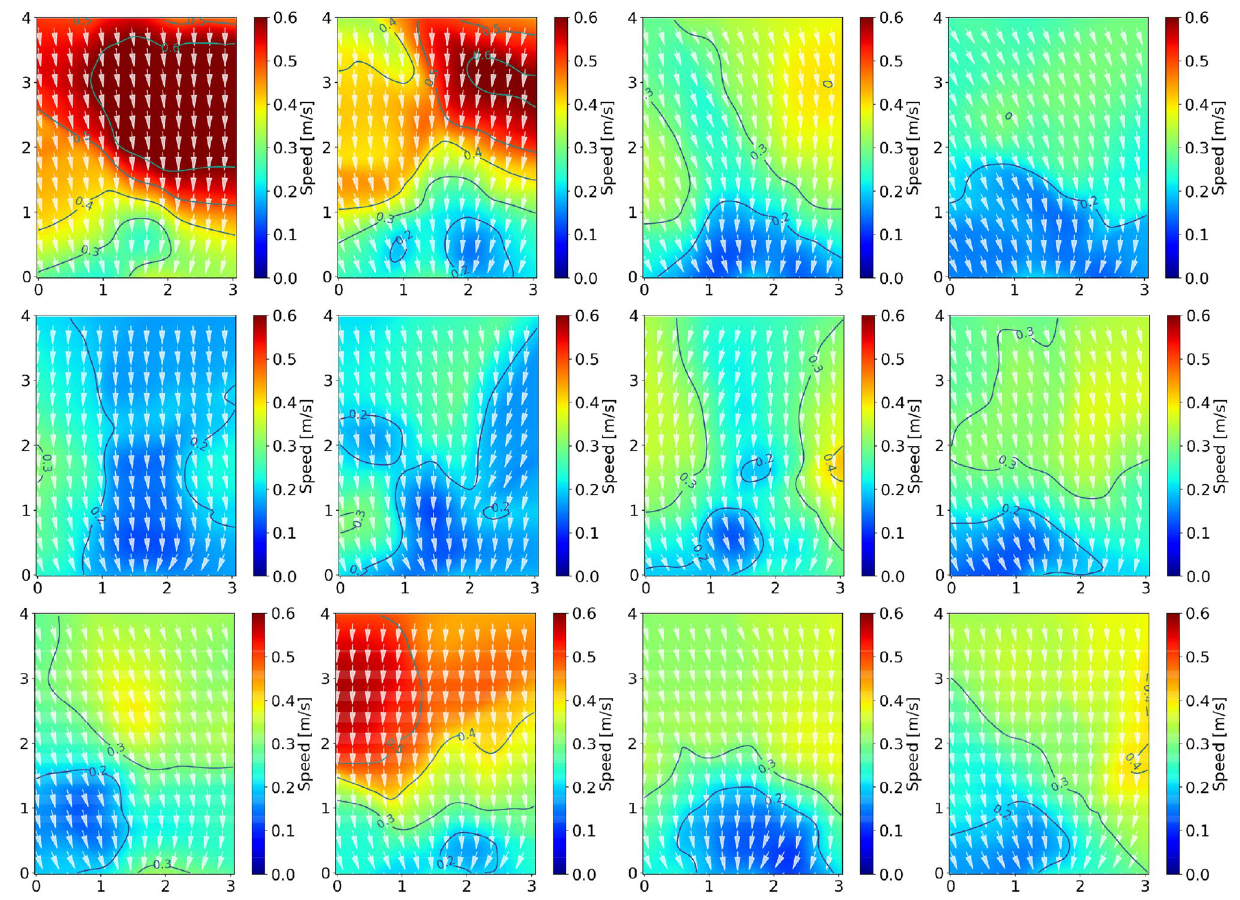
Figure 6. Velocity profiles during the congested stage in this study. Top row: r1, r2, r3, r4; middle row: r5, r6, r7, r8; bottom row: r9, r10, r11, r12. The color represents the value of the velocity and the white arrows represent the direction of the velocity. The dark blue lines represent the speed